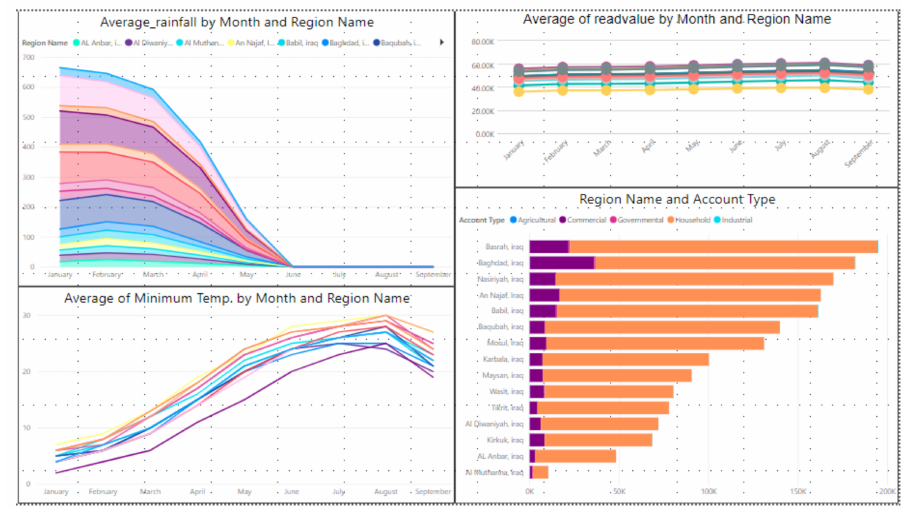
Figure 9. Dynamic Analysis of Rainfall Distribution and Minimum Temperature and Account Types Over Region and Months.